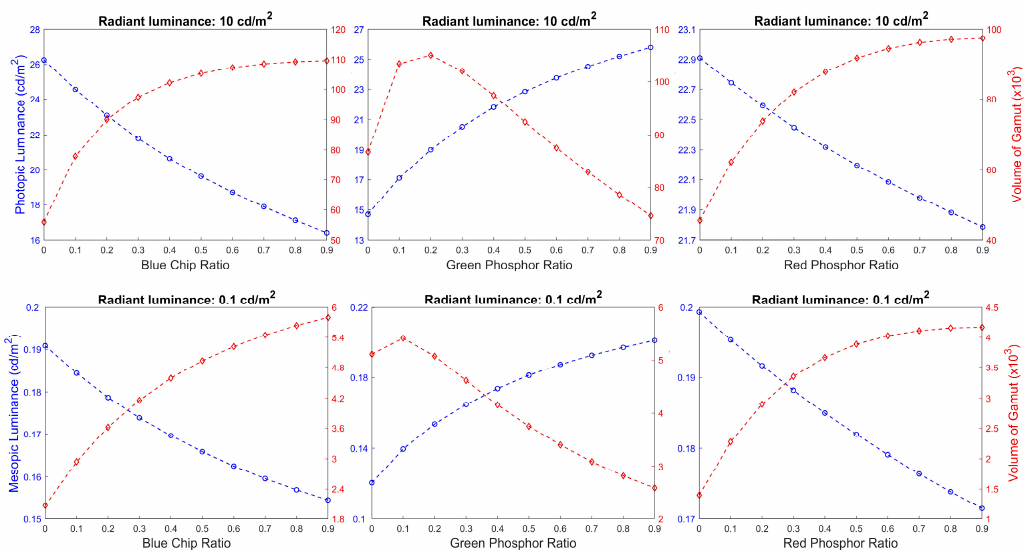
Figure 6. Characteristic of luminance and gamut volume of di ff erent power density ratios (left to right: blue, green, and